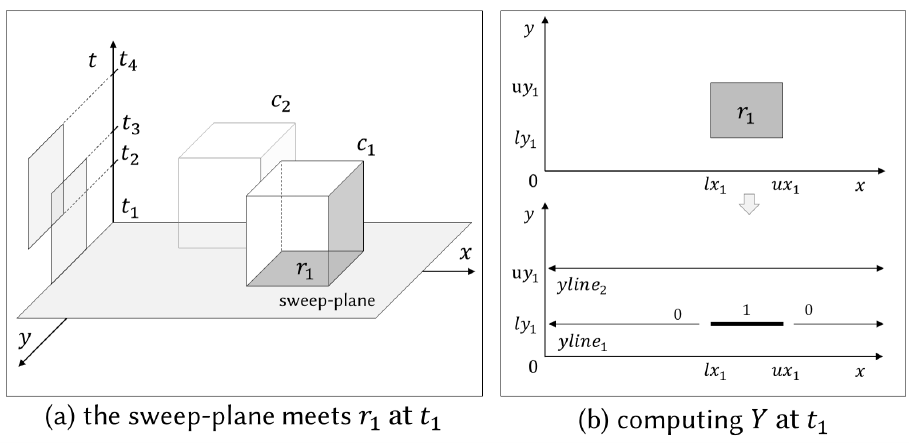
Figure 5. Sweep-plane encounters r 1 at t 1 .